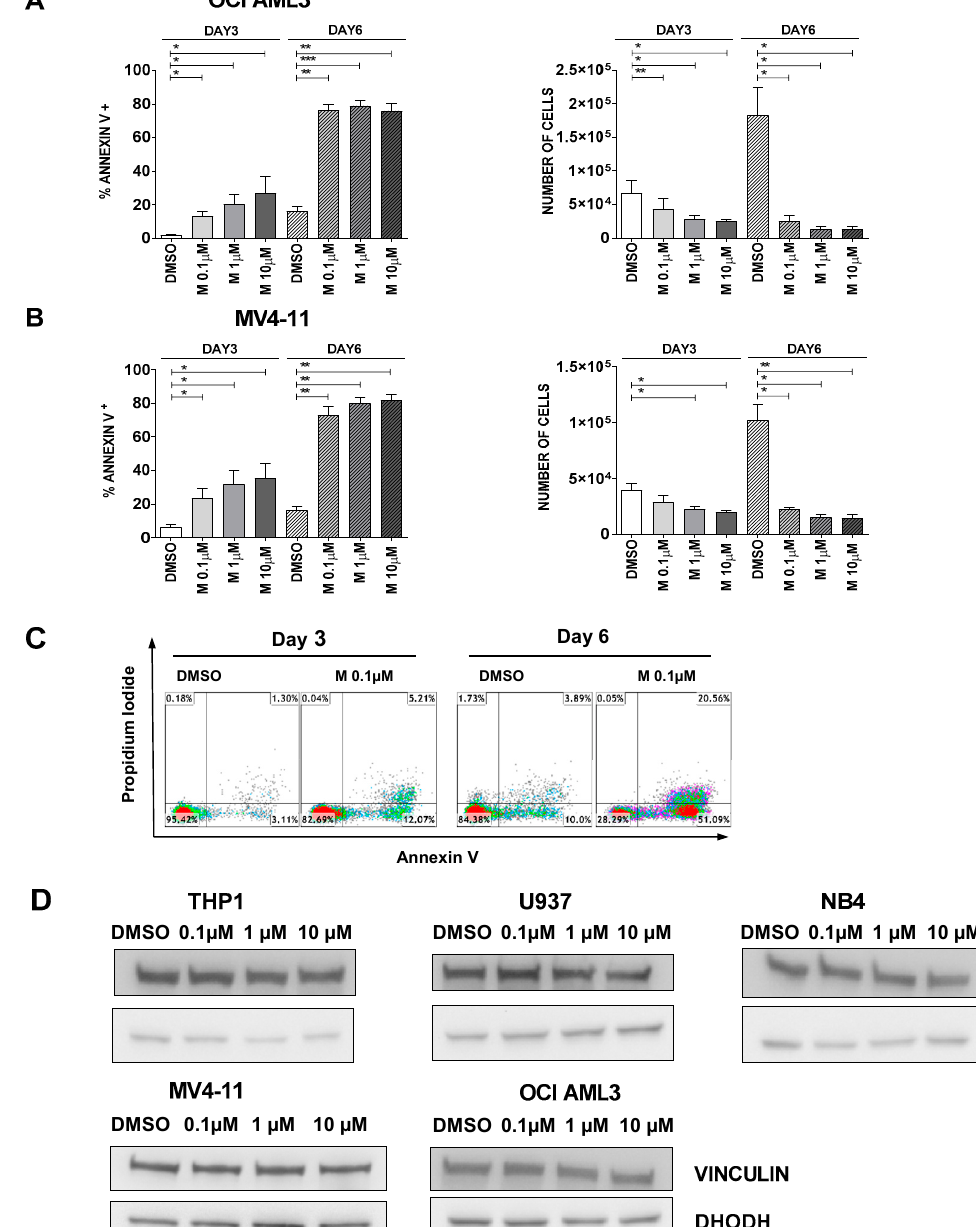
Figure 3. MEDS433 becomes highly effective also in partially resistant cell lines if the time of exposure is increased. ( A , B ) Apoptotic rate and corresponding viable cell counts of OCI AML3 ( A , n = 3) and MV4-11 ( B , n = 3) treated for 3 or 6 days with MEDS433 at different concentrations. ( C ) Flow cytometry plots of a representative experiment of MV4-11 cells treated with MEDS433 for 3 or 6 days. ( D ) Dihydroorotate Dehydrogenase (DHODH) protein levels before and after treatment with MEDS433 at different concentrations. ( n = 3) DMSO: dimethyl sulfoxide. M: MEDS433. Statistical significance: t -test, * p < 0.05; ** p < 0.01; *** p < 0.001.